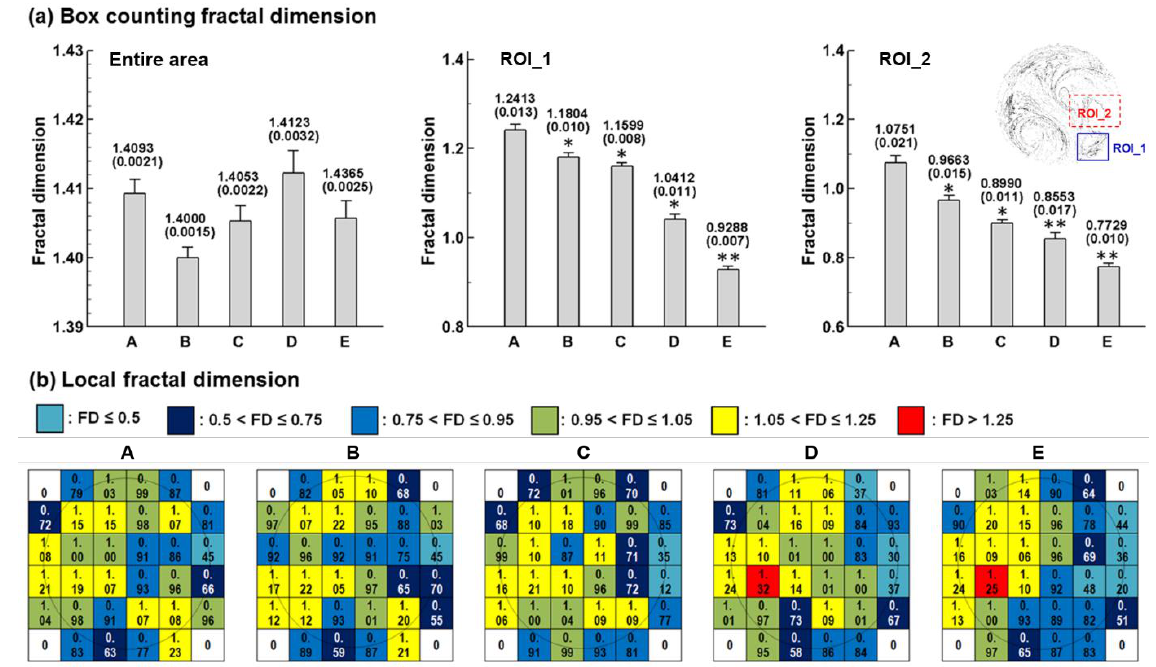
Figure 9. Fractal analysis in the test case 2: ( a ) comparison of fractal dimensions among the five tumor stages for the entire image (left), ROI_1 (middle), and ROI_2 (right); ( b ) FD distribution by dividing the image into a 6 × 6 lattice for the five tumor stages. *: p ≤ 0.05; **: p ≤ 0.01.